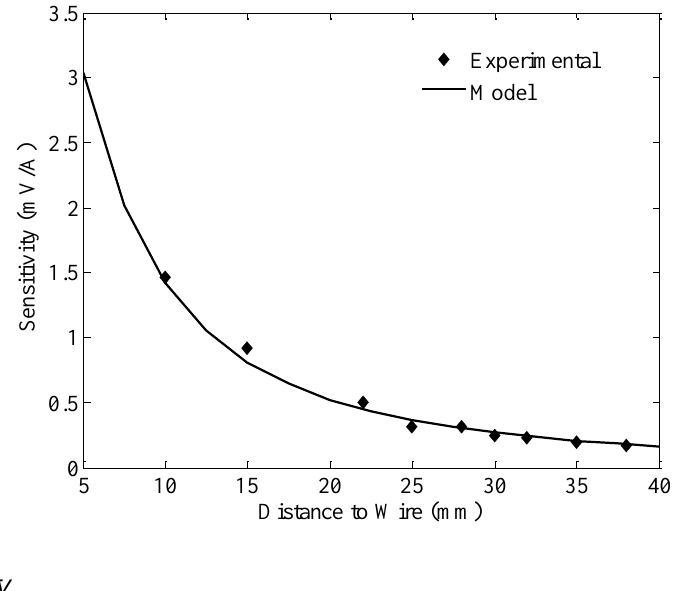
Figure 14. Theoretical and experimental sensor sensitivity.